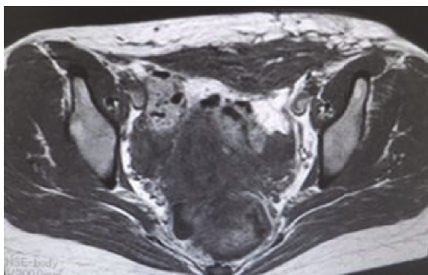
Figure 3: An MRI scan at one postoperative month showed that the rectus abdominis muscle defect had been reconstructed with the vastus lateralis muscle flap.